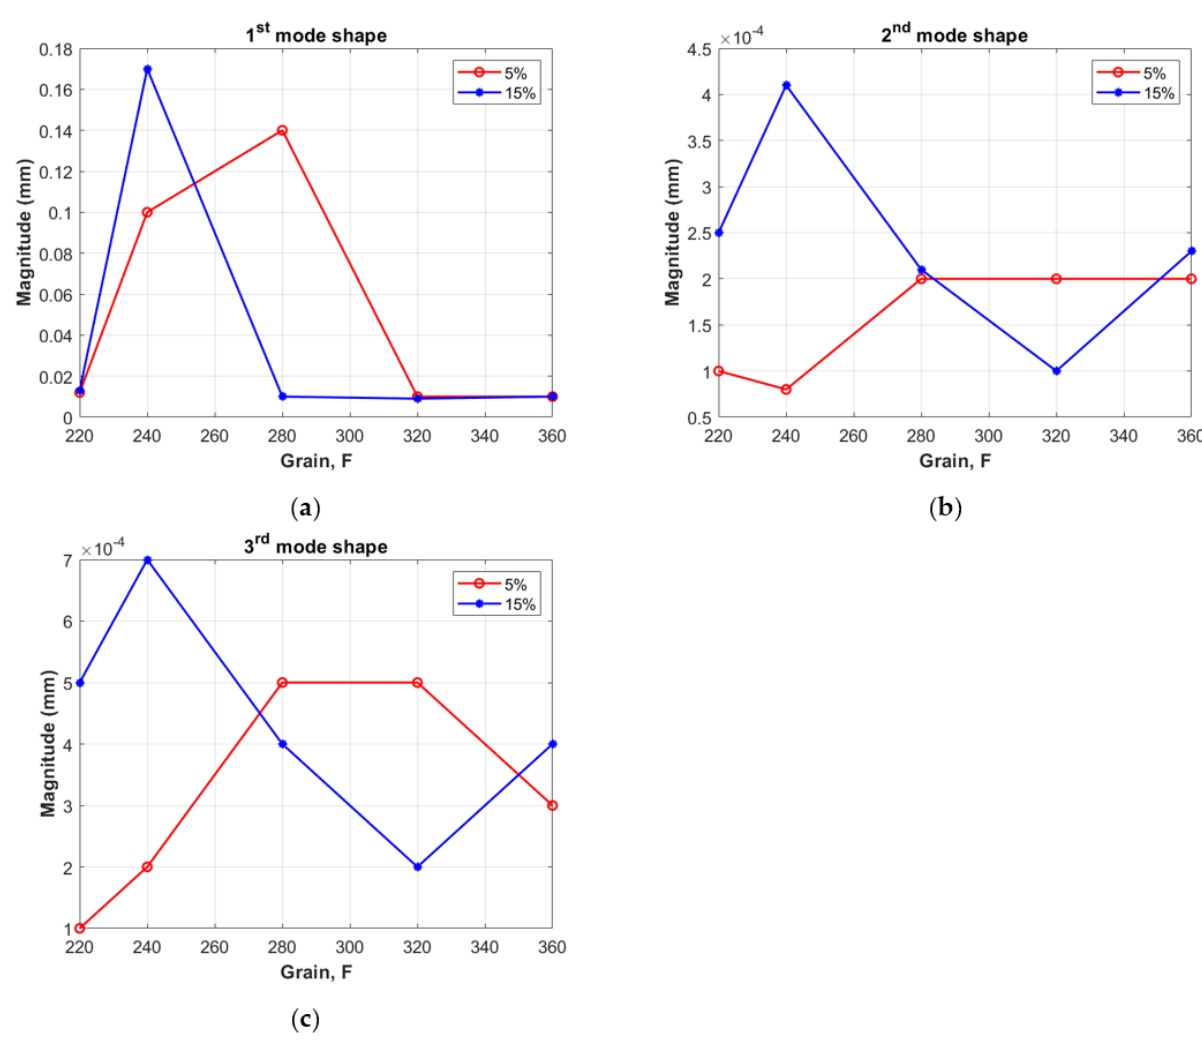
Figure 4. The magnitude of the amplitude responses of the beams via grains of the modifier. Results for the first mode shape ( a ), the second mode shape ( b ), and the third mode shape ( c ), respectively.